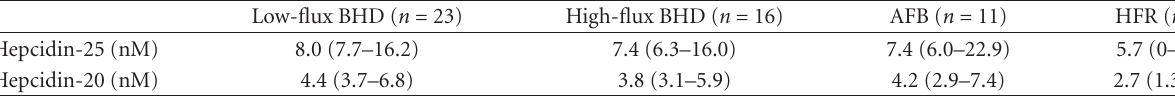
Table 4: Predialysis serum hepcidin-25 and hepcidin-20 levels and the di ff erent HD techniques.